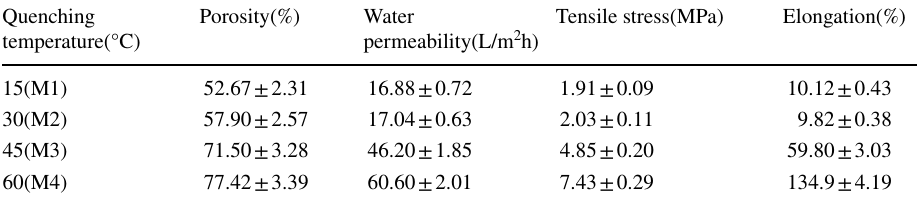
Table 3 Porosity, water permeability, tensile stress and elongation of PVDF membranes produced with different quenching temperatures